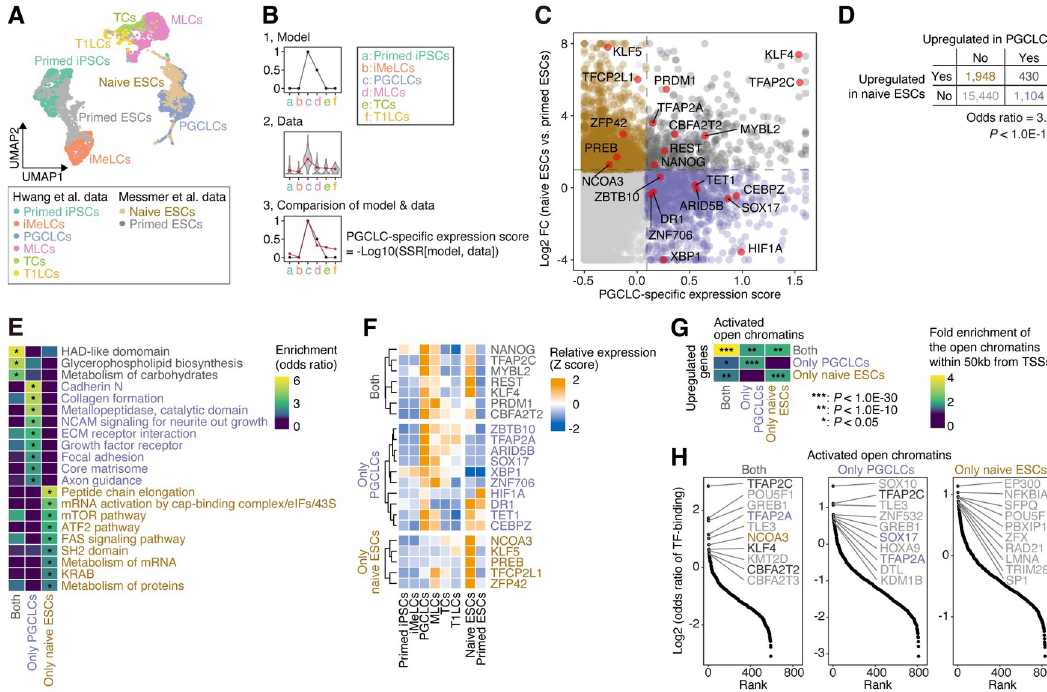
Fig 1. Characterization of the gene expression signature similarity between PGCLCs and na ï ve ESCs. (A) Dimension reduction analysis of scRNA-Seq data using UMAP [62]. Data for in vitro -derived human male germline development [Hwang et al. [10]] and for na ï ve and primed ESCs [Messmer et al. [36]] were integrated and subsequently used. The 3,000 protein-coding genes that were the most differentially expressed among cells were used. (B) Scheme for definition of the PGCLC-specific expression score. For each gene and TE, the sum of squared residuals (SSR) between the model (Panel 1) and the data (i.e., the normalized mean expression value for each cell type; Panel 2) was calculated (Panel 3). Subsequently, the SSR value was − log10-transformed (see Definition of the PGCLC-specific expression score ). (C) Classification of protein-coding genes according to their expression patterns. The X- axis indicates the PGCLC-specific expression score, and the Y-axis indicates the log2 FC of the expression score in na ï ve ESCs vs. primed ESCs. The top 10% of genes with respect to the PGCLC-specific expression score were regarded as the genes upregulated in PGCLCs. Genes with log2 FC values > 1 and FDR values < 0.05 were regarded as upregulated in na ï ve ESCs. The genes were classified into four categories: genes upregulated in both cell types (dark gray), genes upregulated only in PGCLCs (purple), genes upregulated only in na ï ve ESCs (brown) and other genes (light gray). In addition, TFs (except for KZFPs) with elevated expression were annotated. The plot for KZFPs is shown in S3A Fig . (D) Association of the set of genes upregulated in PGCLCs with that in na ï ve ESCs. The P value was calculated with Fisher’s exact test. (E) GO enrichment analysis results for the three gene categories (genes upregulated in both cell types, genes upregulated only in PGCLCs, and genes upregulated only in na ï ve ESCs). The gene sets that exhibited significant enrichment (odds ratio > 2, FDR < 0.05; denoted by an asterisk) in any of the three gene categories are shown. (F) Expression patterns of the TFs annotated in ( C ). A violin plot is shown in S2A Fig . Although TFAP2A was first classified as a gene upregulated in both PGCLCs and na ï ve ESCs, we reclassified it as a gene upregulated only in PGCLCs since its expression in na ï ve ESCs was somewhat low ( Figs 1F and S2A ). (G) Enrichment of activated open chromatin regions in the vicinities of the upregulated genes. Three categories of open chromatin regions, namely those activated in both cell types, only PGCLCs, and only na ï ve ESCs compared to primed ESCs, were detected (log2 FC > 1; FDR < 0.05). Subsequently, for the three categories of open chromatin regions, the degrees of enrichment in the vicinity of ( < 50 kb from) the genes upregulated in both cell types, upregulated only in PGCLCs and upregulated only in na ï ve ESCs were calculated using the GREAT scheme [68] (see Genomic Regions Enrichment of Annotations Tool (GREAT) enrichment analysis ). The P values were calculated with a binomial test. (H) Enrichment of TF-binding events in the open chromatin regions. A publicly available ChIP-Seq dataset provided by the GTRD [39] was used. For each TF, the enrichment (odds ratio) of the binding events in the respective categories of open chromatin regions compared to the other open chromatin regions was calculated. Statistical enrichment was calculated using Fisher’s exact test. Of the TFs with FDR values < 0.05, the top 10 TFs with respect to the odds ratio are annotated. The upregulated TFs shown in ( C ) and ( F ) are